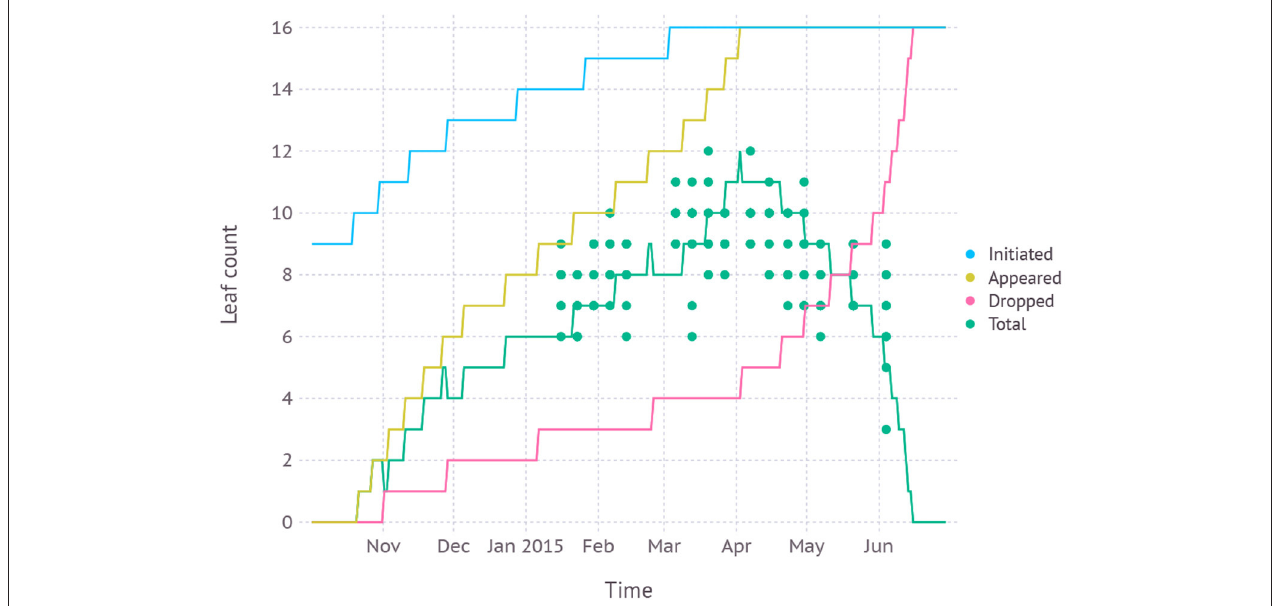
FIGURE 6 | Simulated leaf development phenology compared with fresh leaf count recorded in dataset D1 which was from field measurements and primarily used for evaluating new parameters.